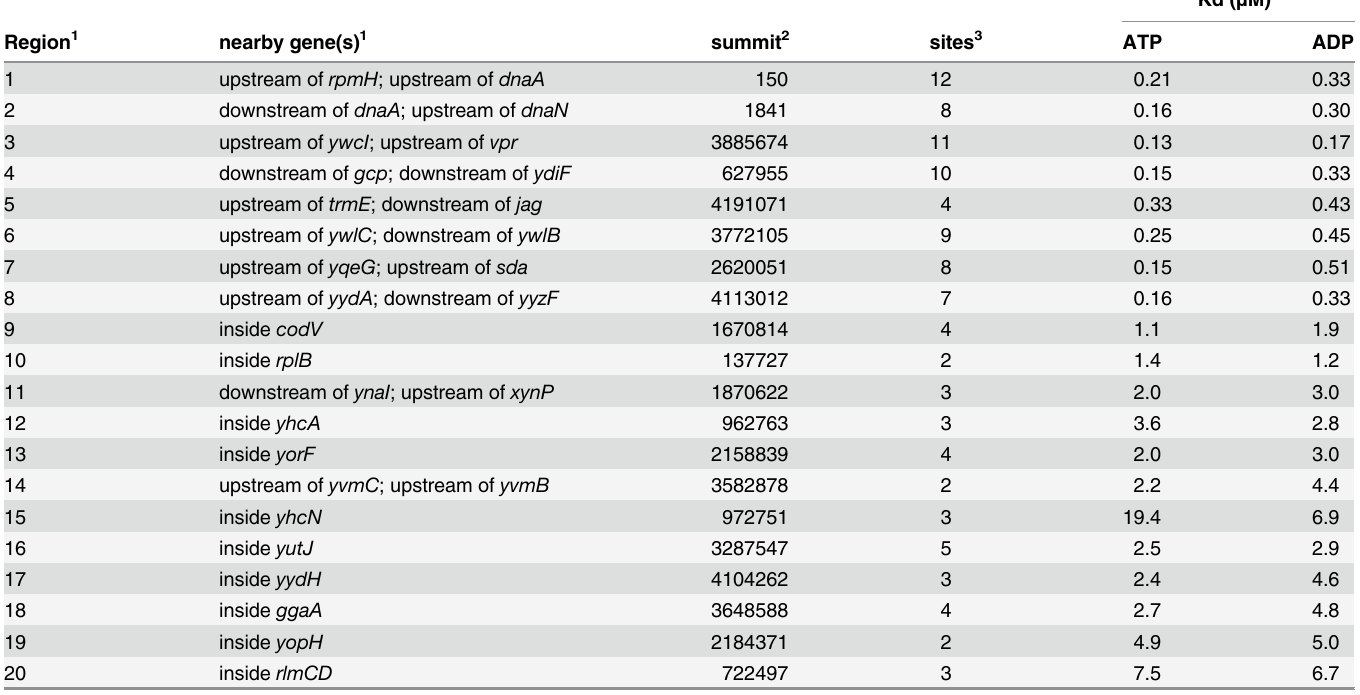
Table 1. Top 20 DnaA binding regions in vitro